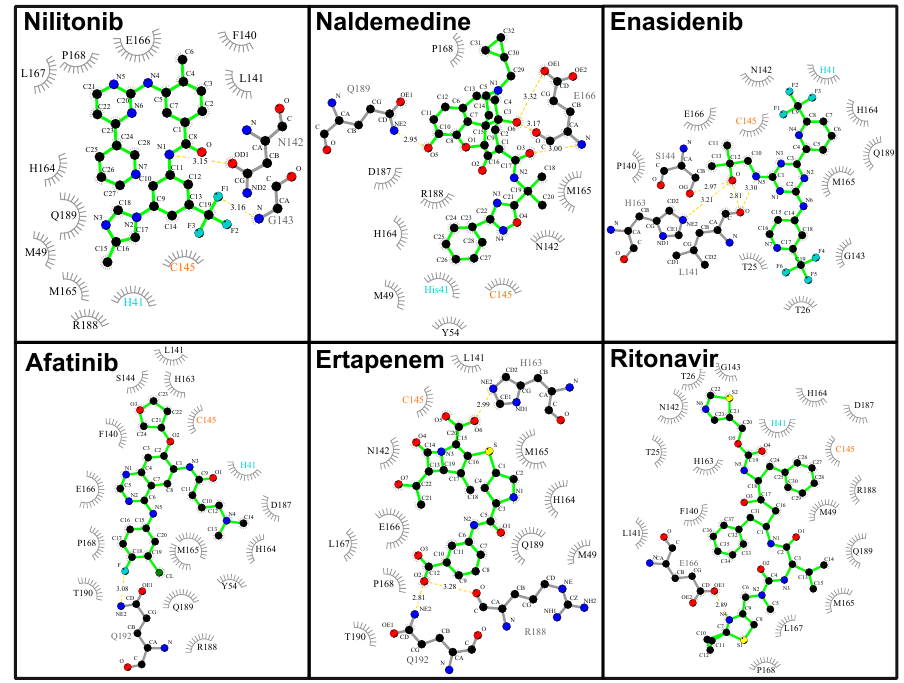
Figure 6. The 3CL pro –compound interactions for the five best FDA-approved drugs and ritonavir. The interactions were analyzed and plotted with LigPlot+ [36,37]. Hydrogen bonds are indicated by orange dashed lines between the atoms involved and the donor–acceptor distance is given in Å, while hydrophobic contacts are represented by gray arcs with spokes radiating towards the ligand atoms they contact. The contacted atoms are shown with spokes radiating